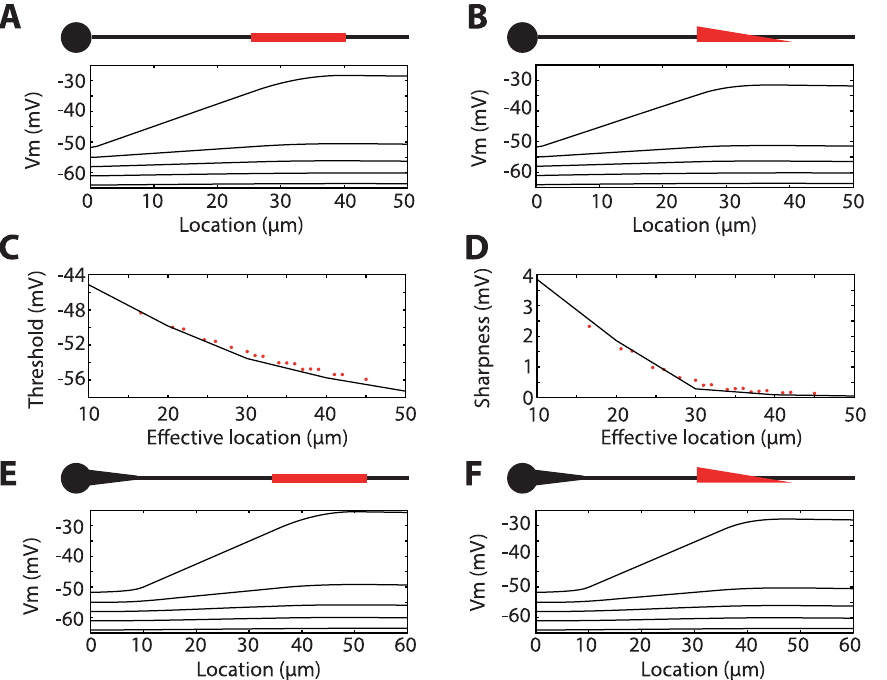
Figure 4. Spatially distributed channels. A, Voltage across the axon as the soma is depolarized by steps of 3 mV (5 values from 2 64 mV to 2 52 mV), with Na channels uniformly distributed between 25 and 40 m m away from the soma (compare with Fig. 1E, same total Na conductance). B, Same as A, but with Na channel density linearly decreasing between 25 and 40 m m. C, Spike threshold defined as the somatic voltage at which half of the sodium channels are activated as function of the location of Na channels when they are clustered at a single point (black). Red dots show the spike threshold when Na channels are uniformly distributed on a segment, as a function of the ‘‘effective’’ location, defined as a point inside the segment (x=0.6 x start + 0.4 x end ). Start points are taken among 1, 10, 20, 25, 30 and 35 m m; end points are taken among 40, 50 and 60 m m. D, Same as C but for initiation sharpness. E, Same as A but a tapering piece of axon is inserted at the beginning (the initial segment is moved), with length 10 m m and diameter linearly decreasing from 4 m m to 1 m m. F, Same as B with the initial tapering.